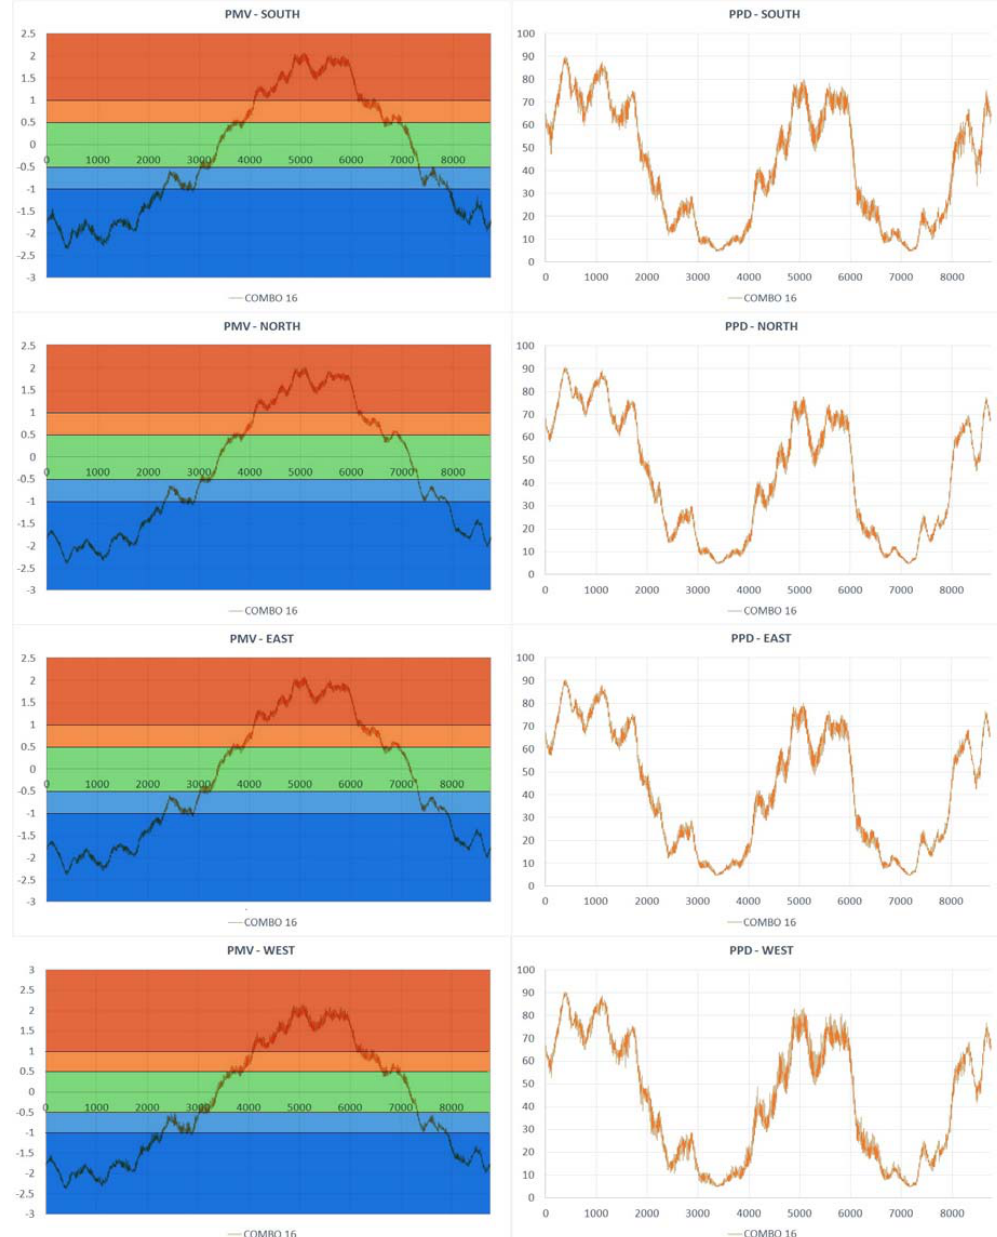
Figure 11. Predicted mean vote (PMV) and predicted percentage of dissatisfied (PPD) evaluation for Combo 16.